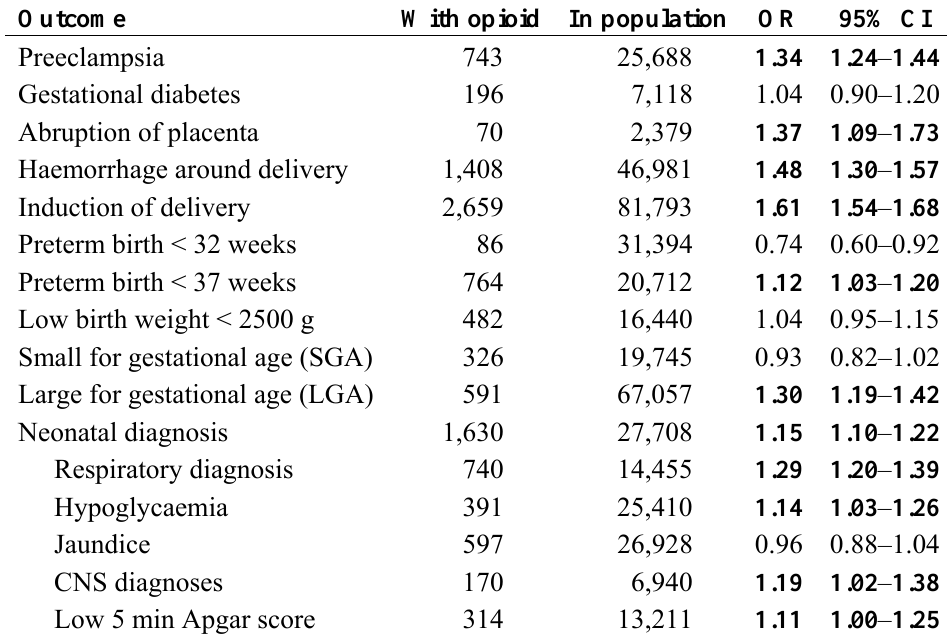
Table 10. Outcomes after maternal use of opioids during the 2nd or 3rd trimester. Bold text shows statistical